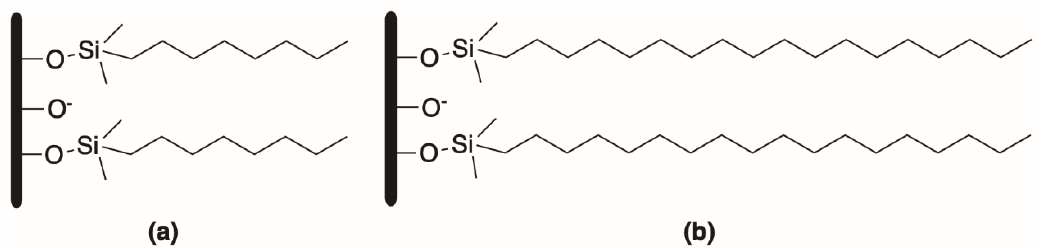
Figure 3. Octyl ( a ) and octadecyl ( b ) silica-based stationary phases.